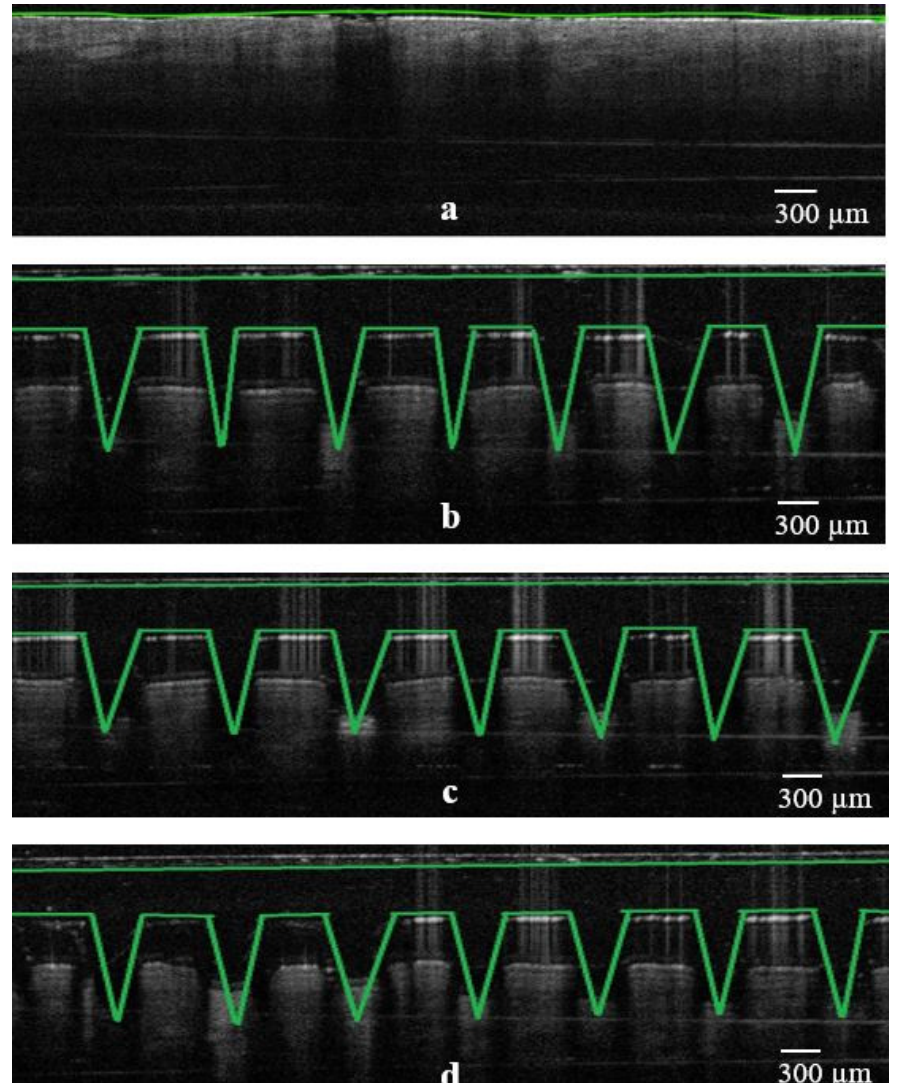
Figure 8. False color 2D still images of 3D-printed MNs (4-sided pyramid design; 4P1, 4P2 and 4P3) showing the real-time penetration into the mouse skin using OCT. ( a ) Skin sample as control before experiment; ( b ) insertion of 4P1 design; ( c ) insertion of 4P2 design; ( d ) insertion of 4P3 design, respectively (scale bar 100 μ m).